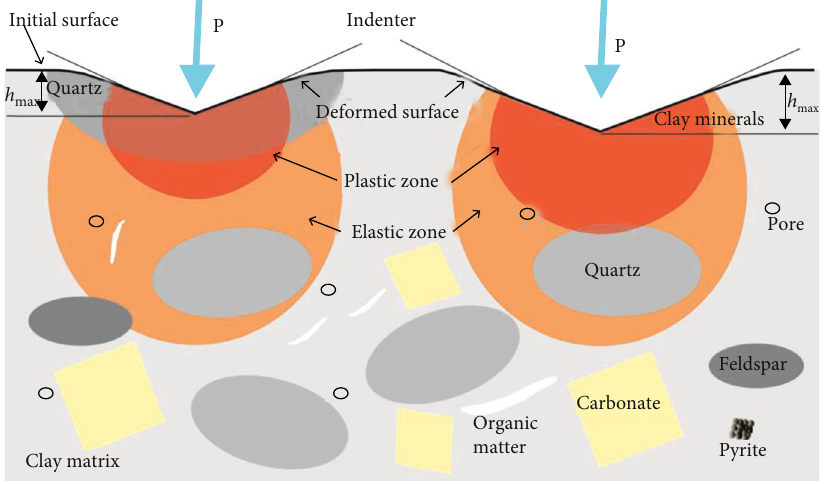
Figure 12: Schematic diagram of the nanoindentation performed on quartz and clay minerals in shale